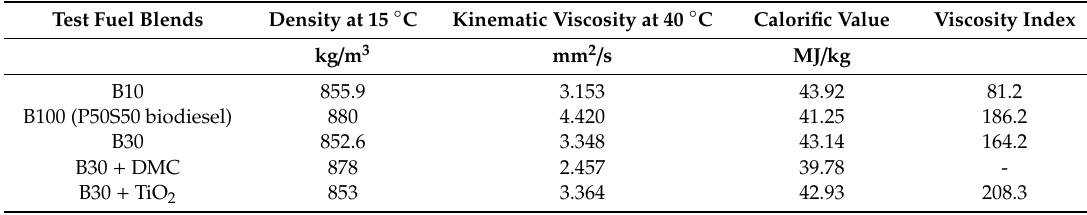
Table 2. Properties of tested fuel samples. DMC—dimethyl